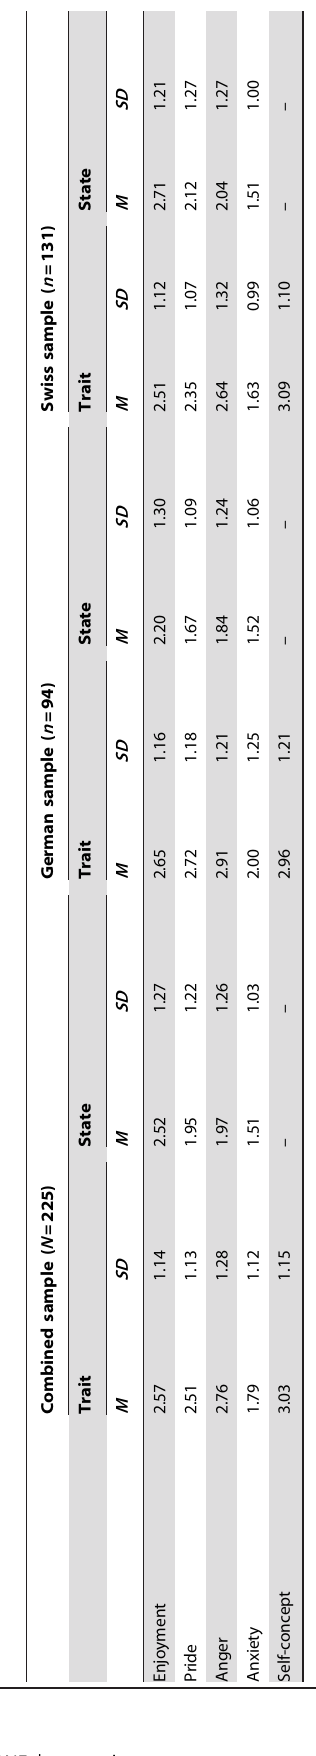
The reliability of the self-concept scale was satisfying (German sample: a = .91; Swiss sample: a = .86). Table 1 shows means and standard deviations of variables for the combined sample and the German and Swiss samples separately. As expected, trait ratings are higher than state ratings for every emotion in both samples. The only exception is that state enjoyment in the Swiss sample was rated higher than trait enjoyment .